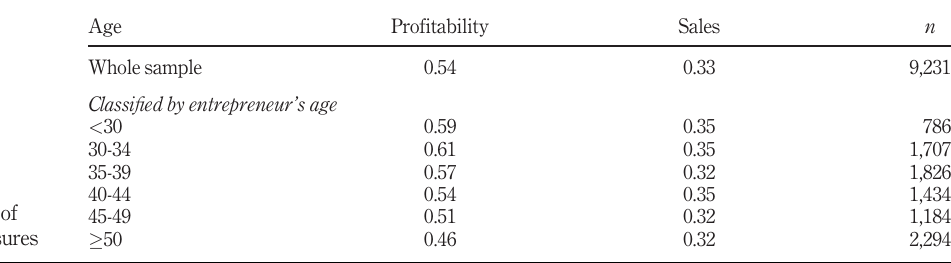
Table I. Mean values of success